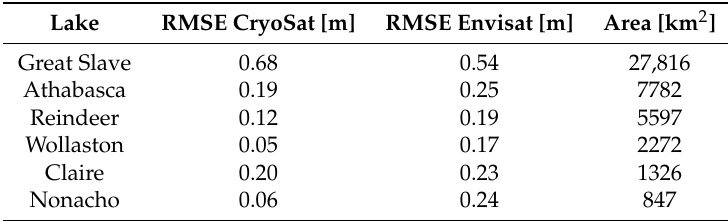
Table 1. RMSE values for CryoSat-2 and Envisat.